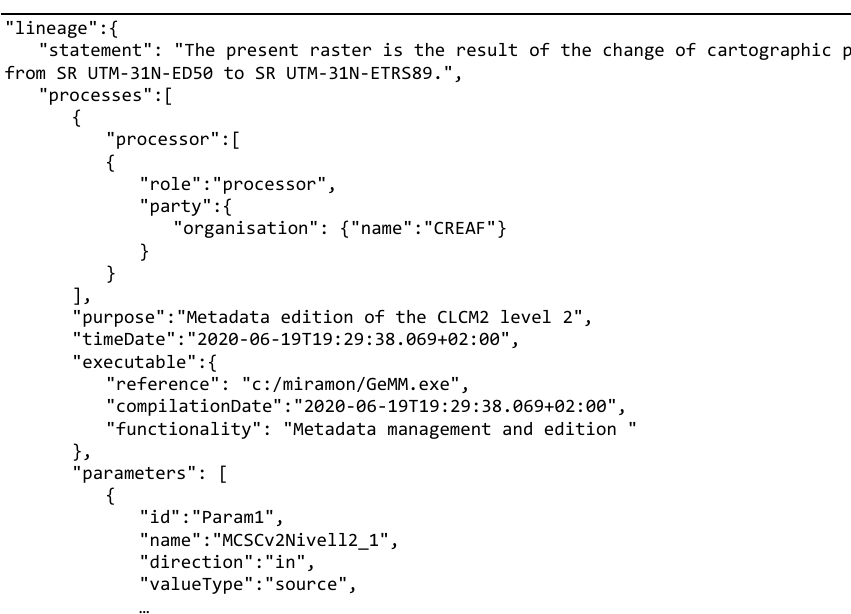
Figure 8. Fragment of the CSW GetRecordById operation response in JSON.